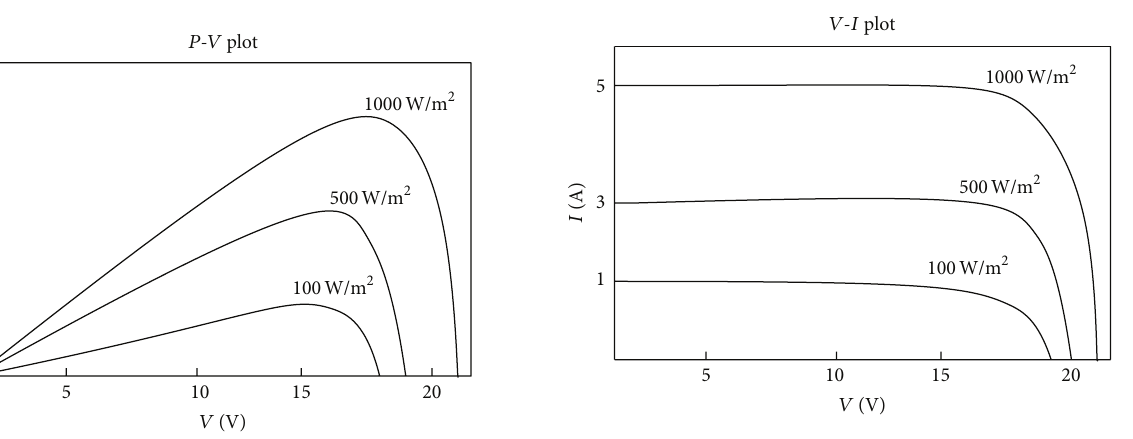
Figure 8: Characteristics curve for Kyocera KC85T 87W module . 𝑉 - 𝐼 curves of KC85T 87 W at different radiations.